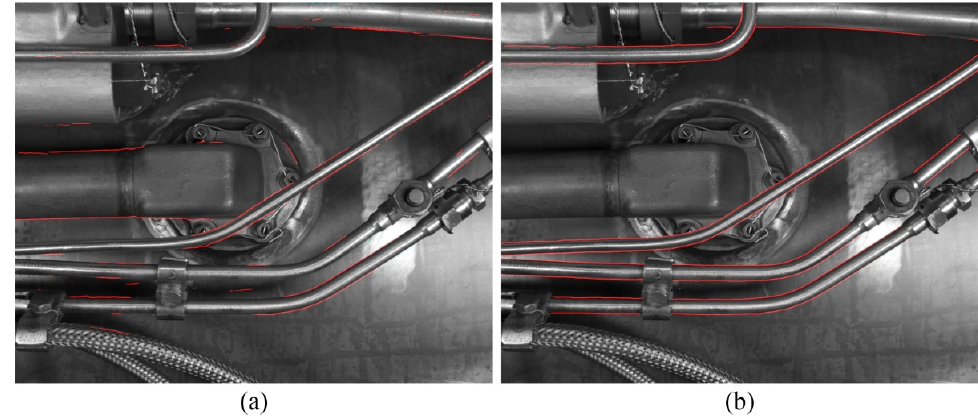
Figure 17. The detection effect of tube contours under a new scenario. ( a ) Using an FCN model trained on the METCD; ( b ) using an FCN model retrained on the new labeled dataset.